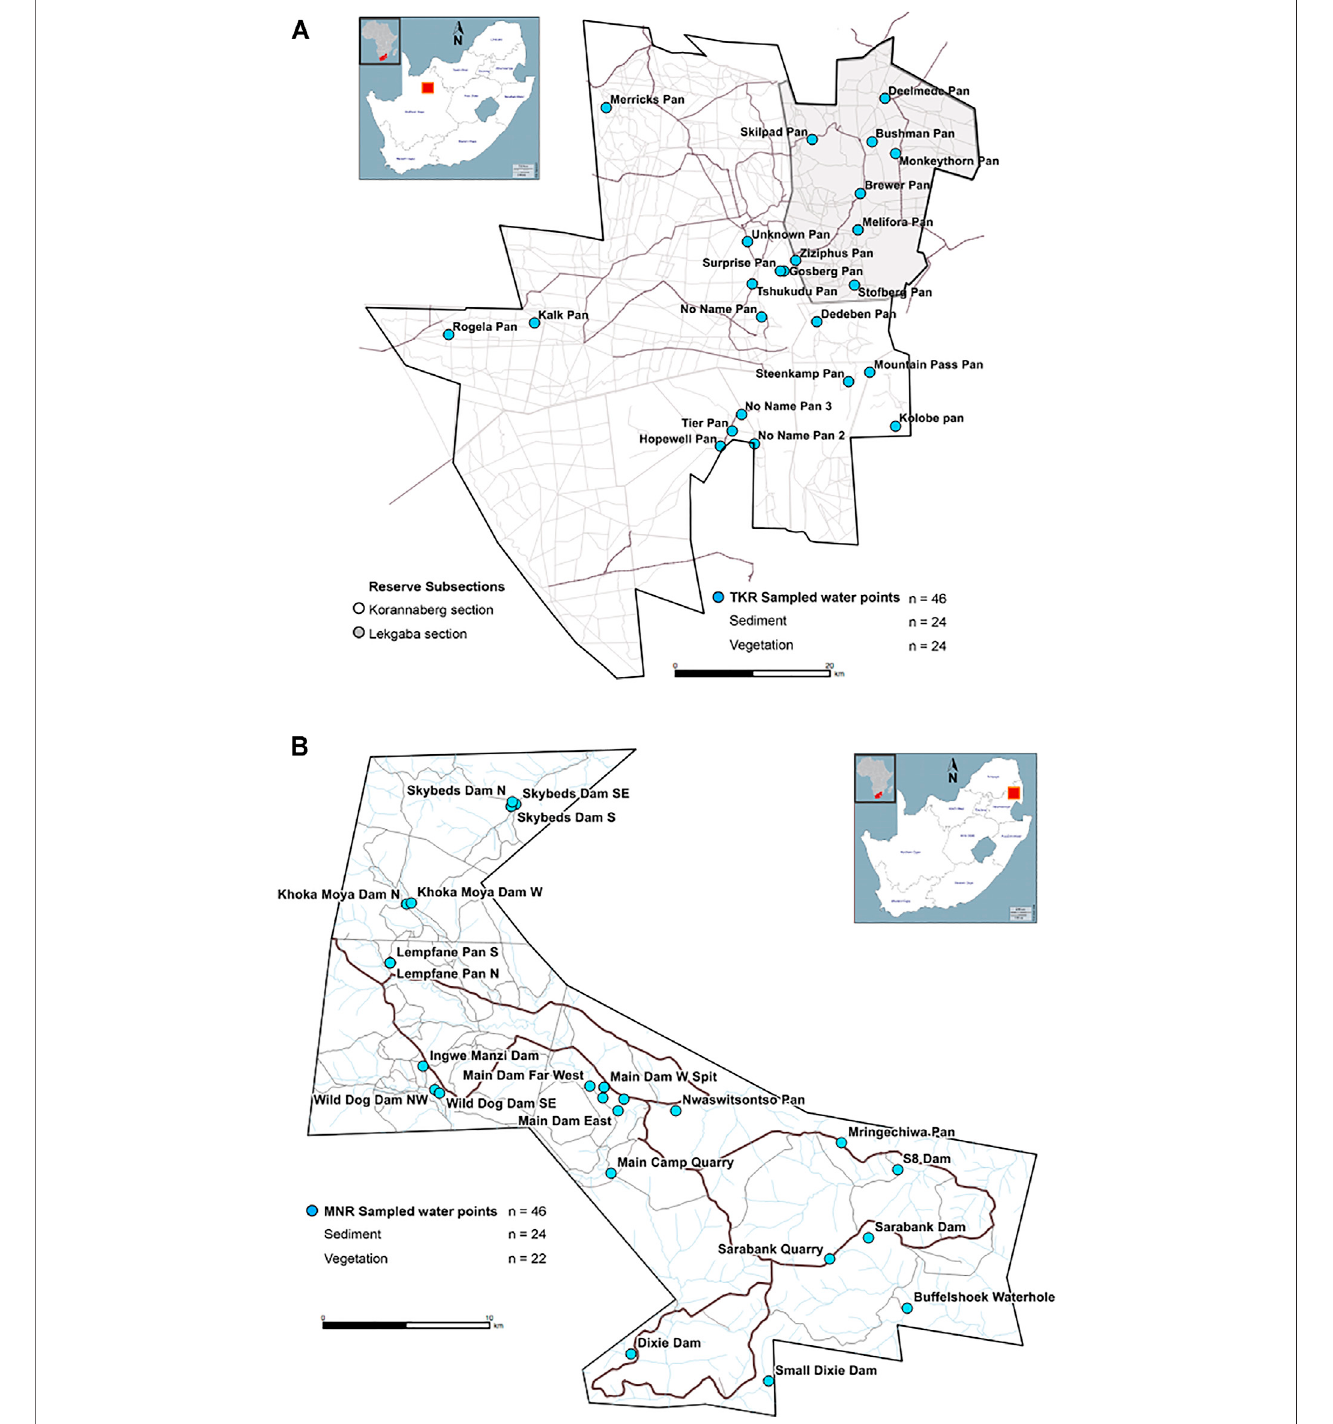
FIGURE 1 | Tswalu Kalahari Reserve (1A) within the arid Northern Cape Province South Africa, showing fenced boundaries and the Korannaberg (white: ± 101,000 ha)andLekgabasections(grey: ± 20,000 ha).ManyeletiNatureReserve (1B) withinthemesicMpumalangaLowveldofSouthAfricawithunfencedboundaries to the northwest (Associated Private Nature Reserves, east (Kruger National Park) and South (Sabi Sand Game Reserve).